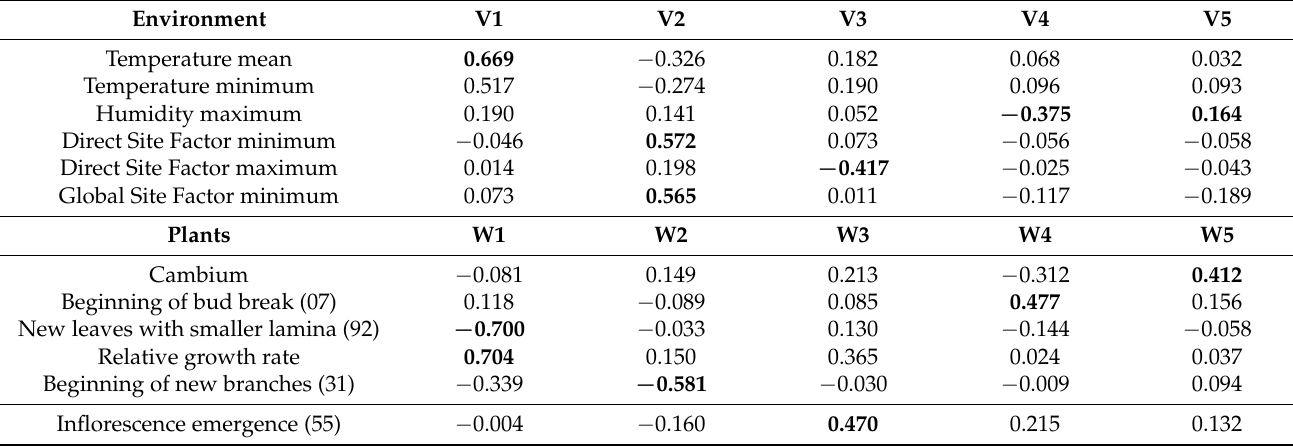
Table 4. Canonical cross-loadings of the first five pairs of canonical variables of environment with cambium and phenology of Alchemilla procumbens . Bold indicates the environmental or plant variables with the highest values.